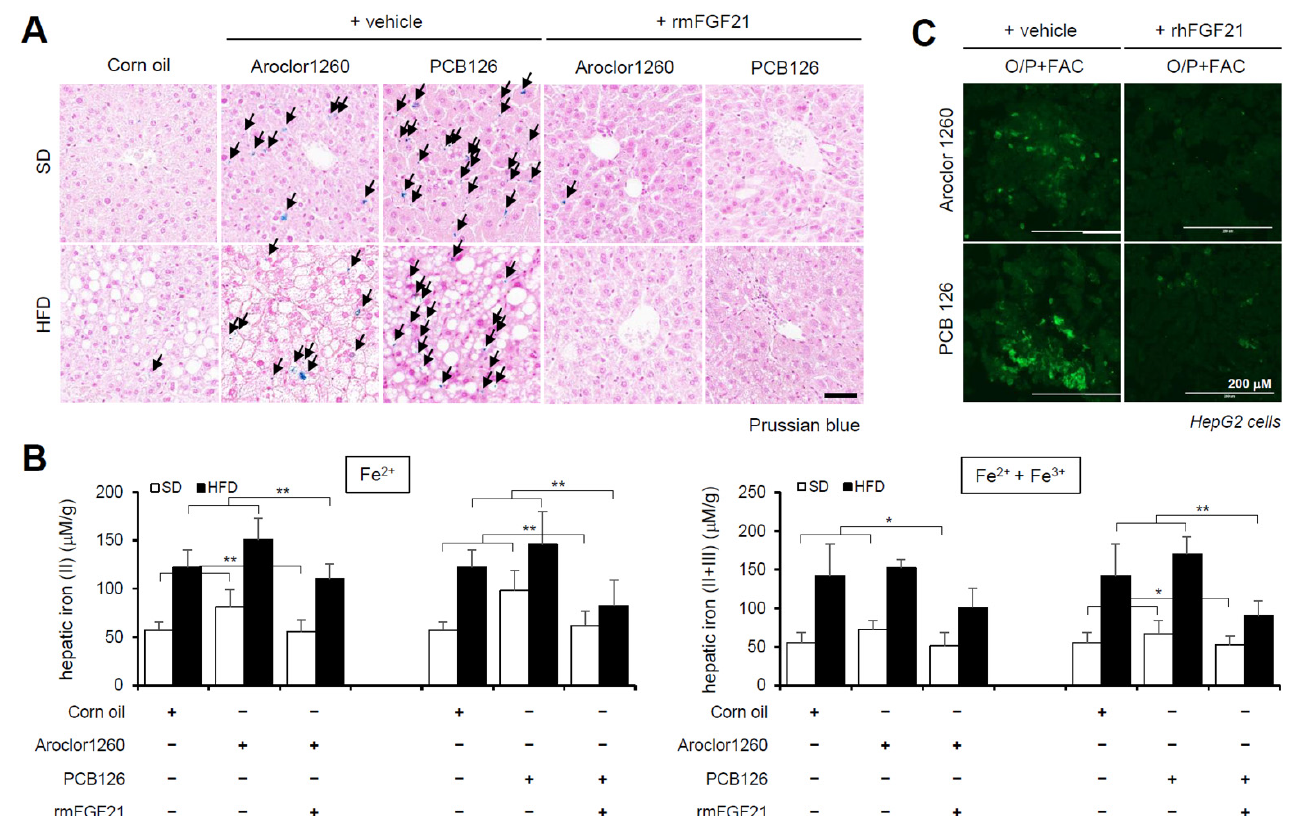
Figure 5. Recombinant FGF21 attenuates hepatic iron overload in PCB-induced NAFLD/NASH models. Aroclor1260 (20 mg/kg)- or PCB126 (5 mg/kg)-injected mice fed either a SD or HFD were intraperitoneally administered vehicle or rmFGF21 (1 mg/kg/day) once daily for 10 days. ( A ) Prussian blue staining showing marked iron accumulation in liver samples. Scale bar: 50 µ m. ( B ) Hepatic iron levels in PCB-induced NAFLD/NASH mice that were intraperitoneally administered vehicle or rmFGF21 (left panel, ferrous ion level; right panel, ferrous and ferric iron total levels). All values represent the mean ± SD, n = 7–10 mice per group. * p < 0.05 and ** p < 0.01. ( C ) Detection of intracellular ferrous ions (Fe 2+ ) using the fluorescent probe FerroFarRed in O/P- and FAC-cotreated HepG2 cells. Scale bar: 200 μ m.